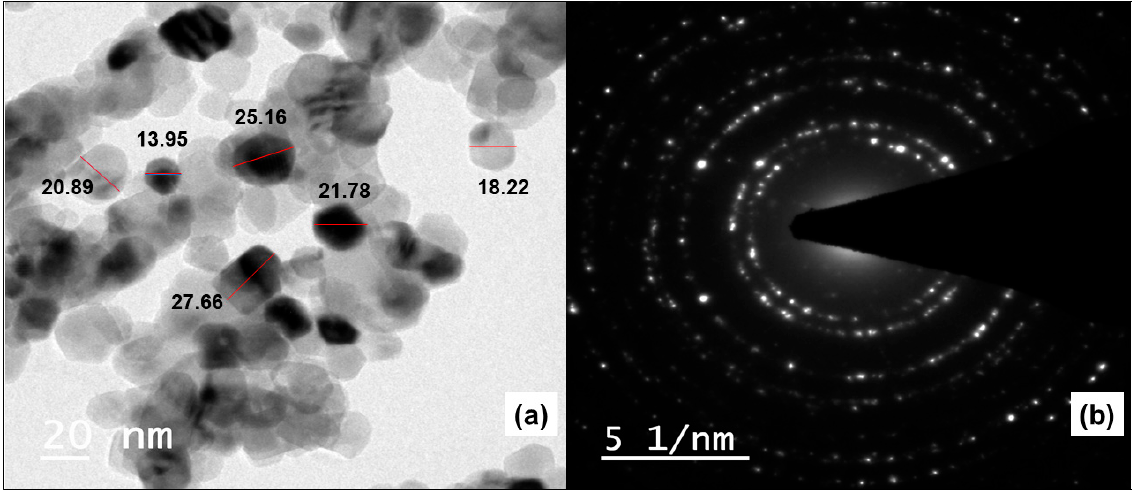
Figure 8. ( a ) TEM image, and ( b ) SAED pattern of the greenly synthesized Ni/NiO NPs.